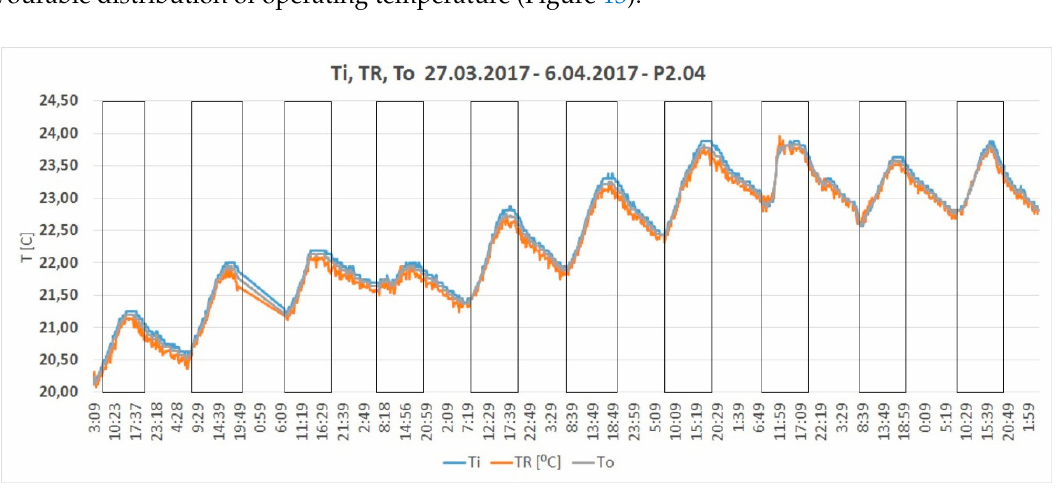
Figure 12. Wavelength of outdoor and indoor temperatures in room P2.04—with external sun- shading devices.